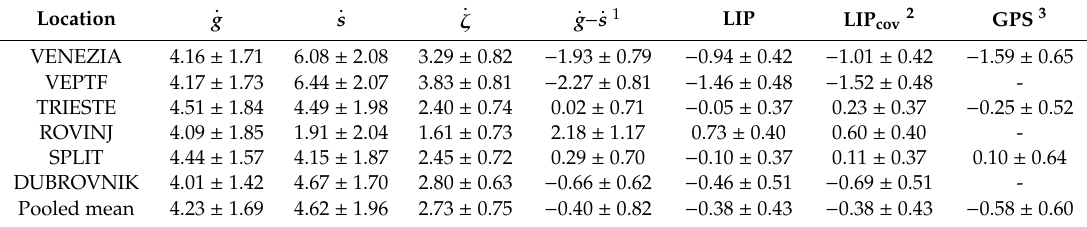
Table 3. Results of calculations using C3S altimetry dataset (1993–2015). Column 1: location; columns 2 / 3: absolute / relative sea level rates in the altimetry era; column 4: relative sea level rates during TG lifetime; column 5: VLM calculated with classical approach (ALT-TG); columns 6–8: VLM derived with LIP and LIP cov approaches and observed by CGPS. All data are in mm y − 1 .